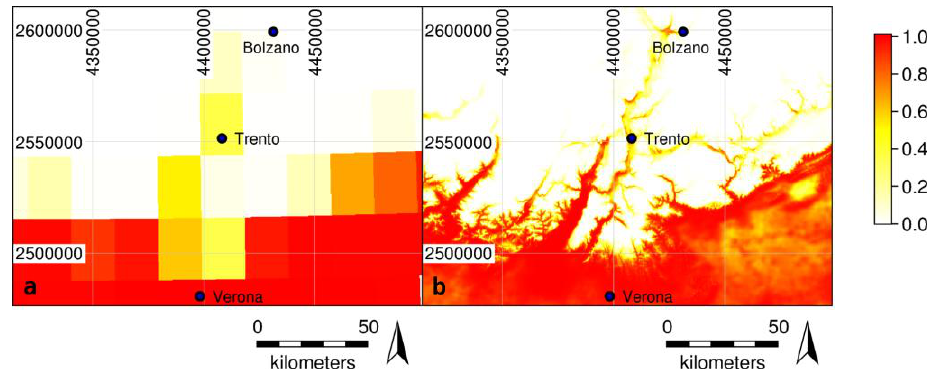
Figure 6. Spatial resolution influencing habitat suitability models. The values indicate the probability that any existing diapause eggs of the tiger mosquito, Aedes albopictus , would have survived the winter 2011/2012 in Northern Italy based on ( a ) commonly used (e.g., the European Center for Disease Control ECDC) ECA&D data; and ( b ) reconstructed MODIS LST. All data are in Lambert azimuthal equal area projection (EPSG code: 3035). The extents in geographical degrees of (a) and (b) are approximately